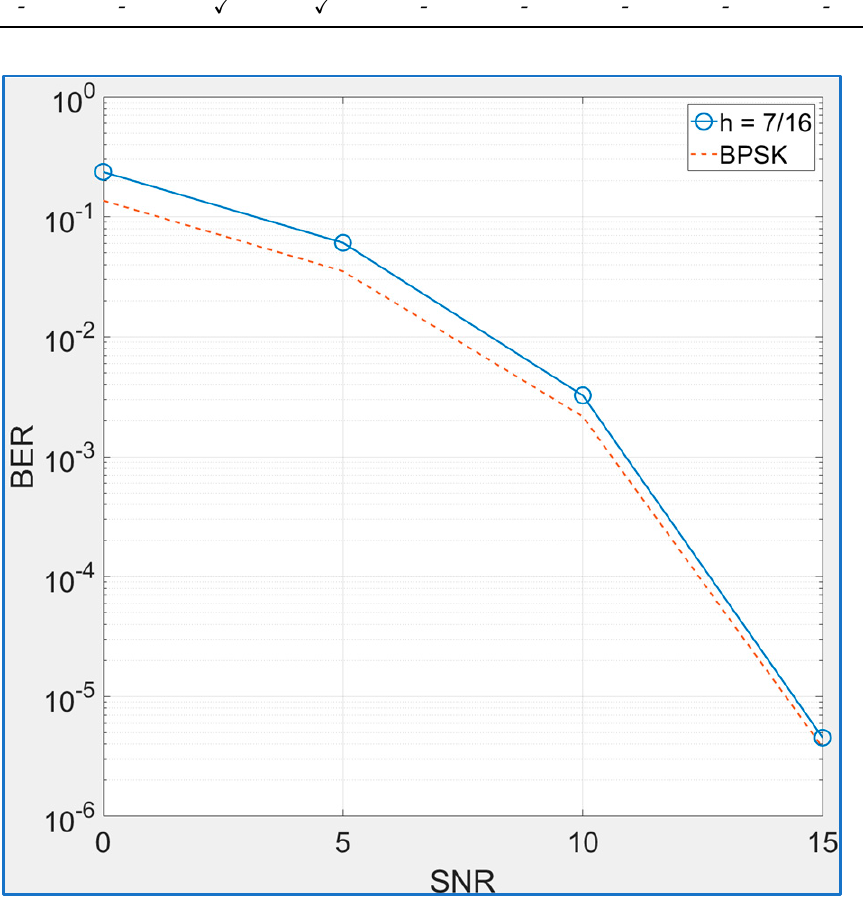
Figure 12. BER performance of binary CPM-GFDM vs. BPSK-GFDM for matched filter receiver over frequency-selective channels .